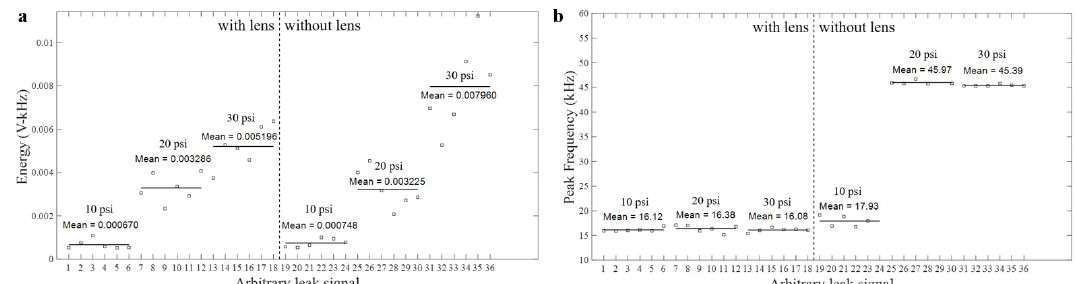
Figure 11. ( a ) Spectral energy of six selected acoustic emission (AE) signals for each pressure and pipe state in the frequency range of 10–30 kHz, ( b ) peak frequencies of six selected AE signals for each pressure and pipe